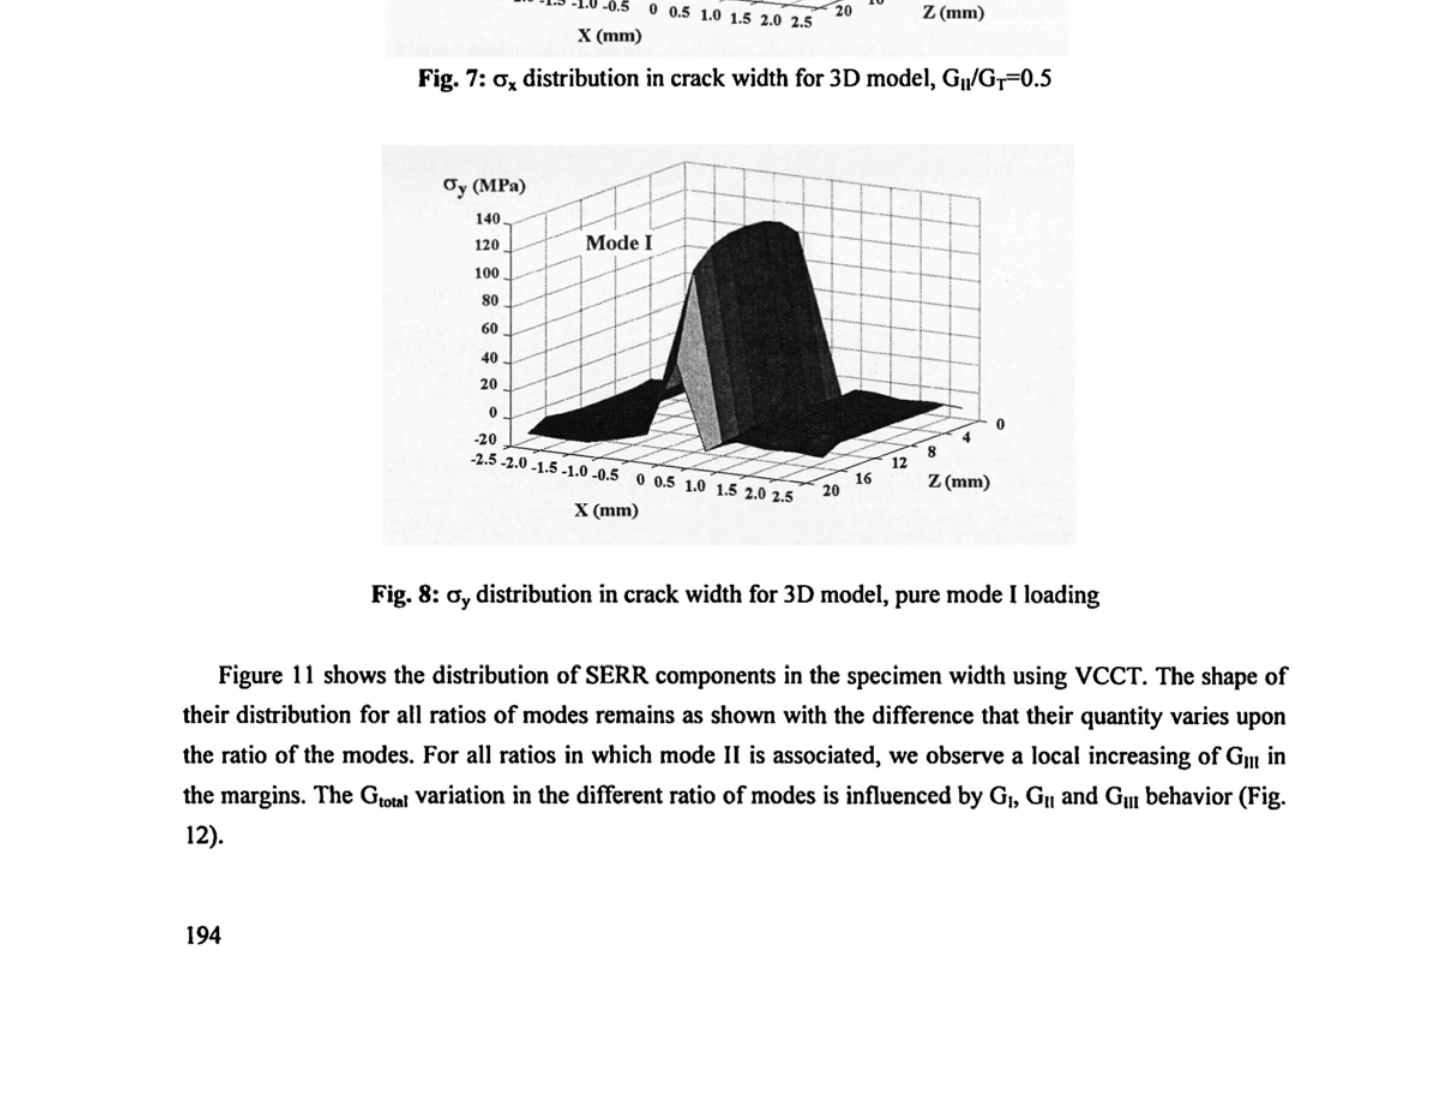
Fig. 7: σ distribution in crack width for 3D model, χ